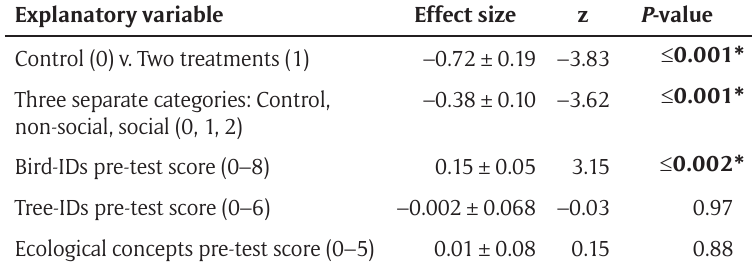
Table 5: Post-test bias. Results of Generalized Linear Models to determine the effect of treatment and pre-test score on the tendency for participants to take (1) the post-test or not (0) (binomial response variable). N = 560 participants.